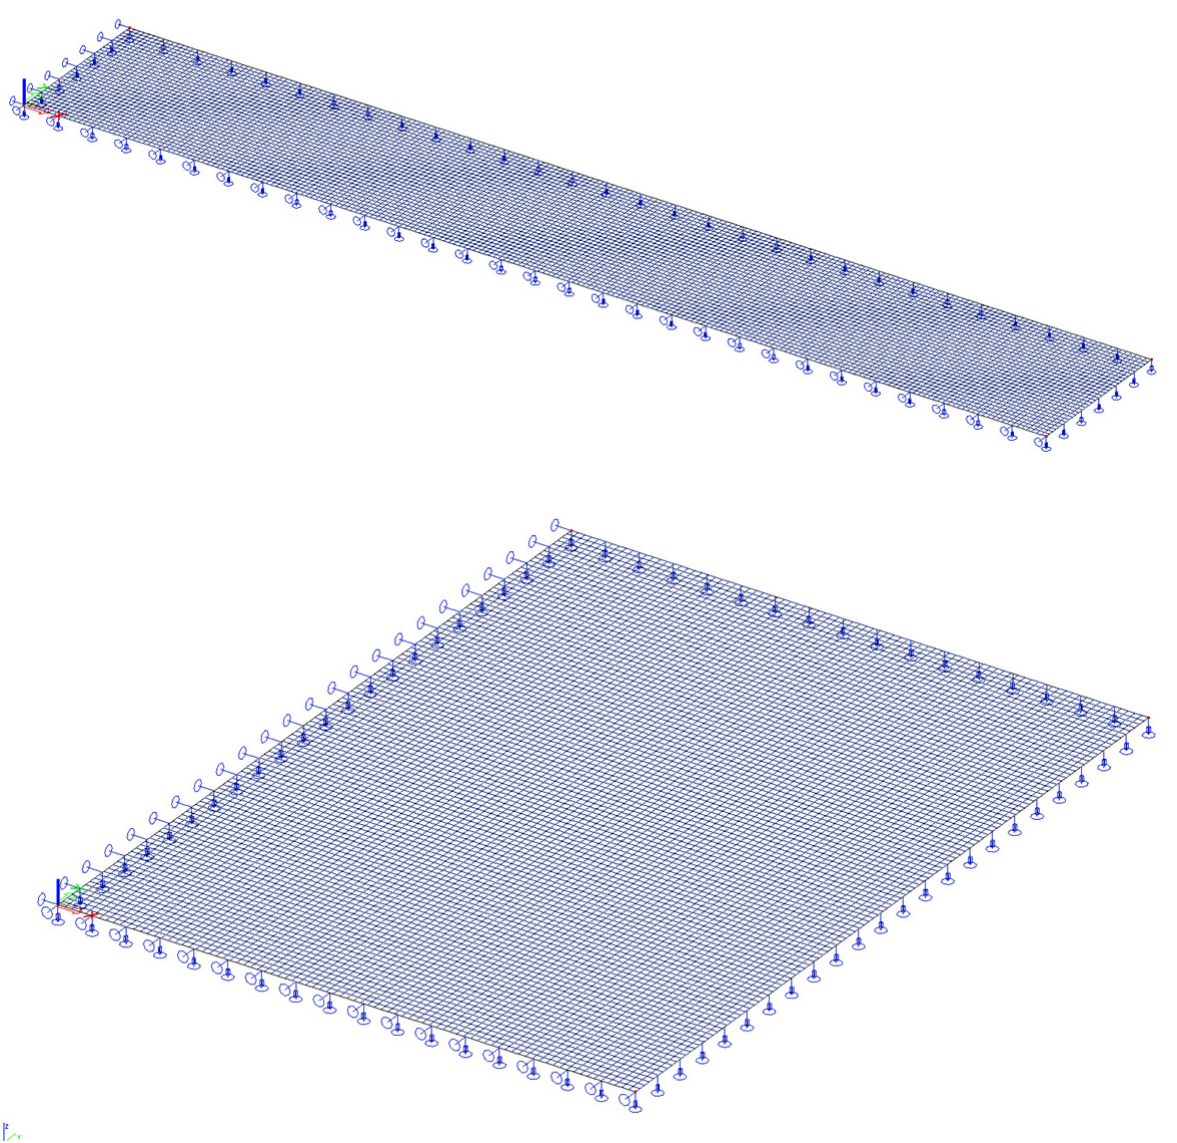
Fig. 5 Finite element model of floor pane (top) and end wall pane (below)